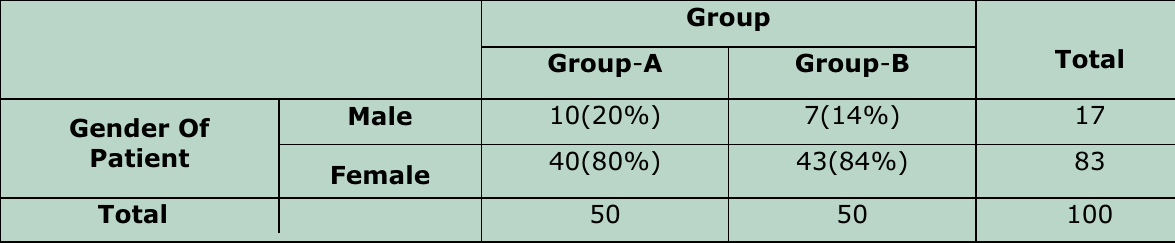
Table-II: Gender distribution of patients in treatment groups.